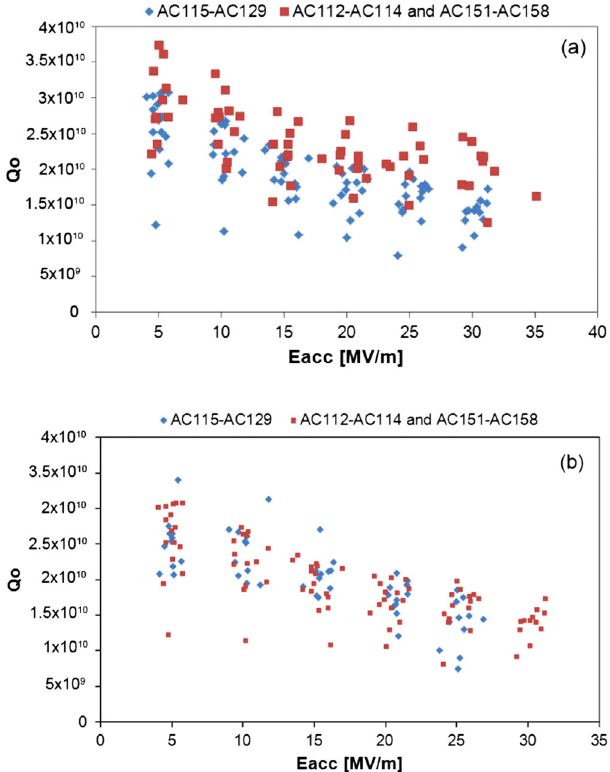
FIG. 14. (a) Comparison of unloaded quality factor Q 0 at 2 K for 11 EP-treated LG cavities (red) with Q 0 at 2 K of XFEL prototype cavities (AC115–AC129, best result) treated according to XFEL recipe (partly final EP and partly BCP flash [24] were applied) (blue). (b) Comparison of unloaded quality factor Q 0 at 2 K for 11 BCP-treated LG cavities (red) with Q 0 at 2 K of XFEL prototype cavities (AC115–AC129, best result) treated according XFEL recipe (partly final EP and partly BCP flash [24] were applied)